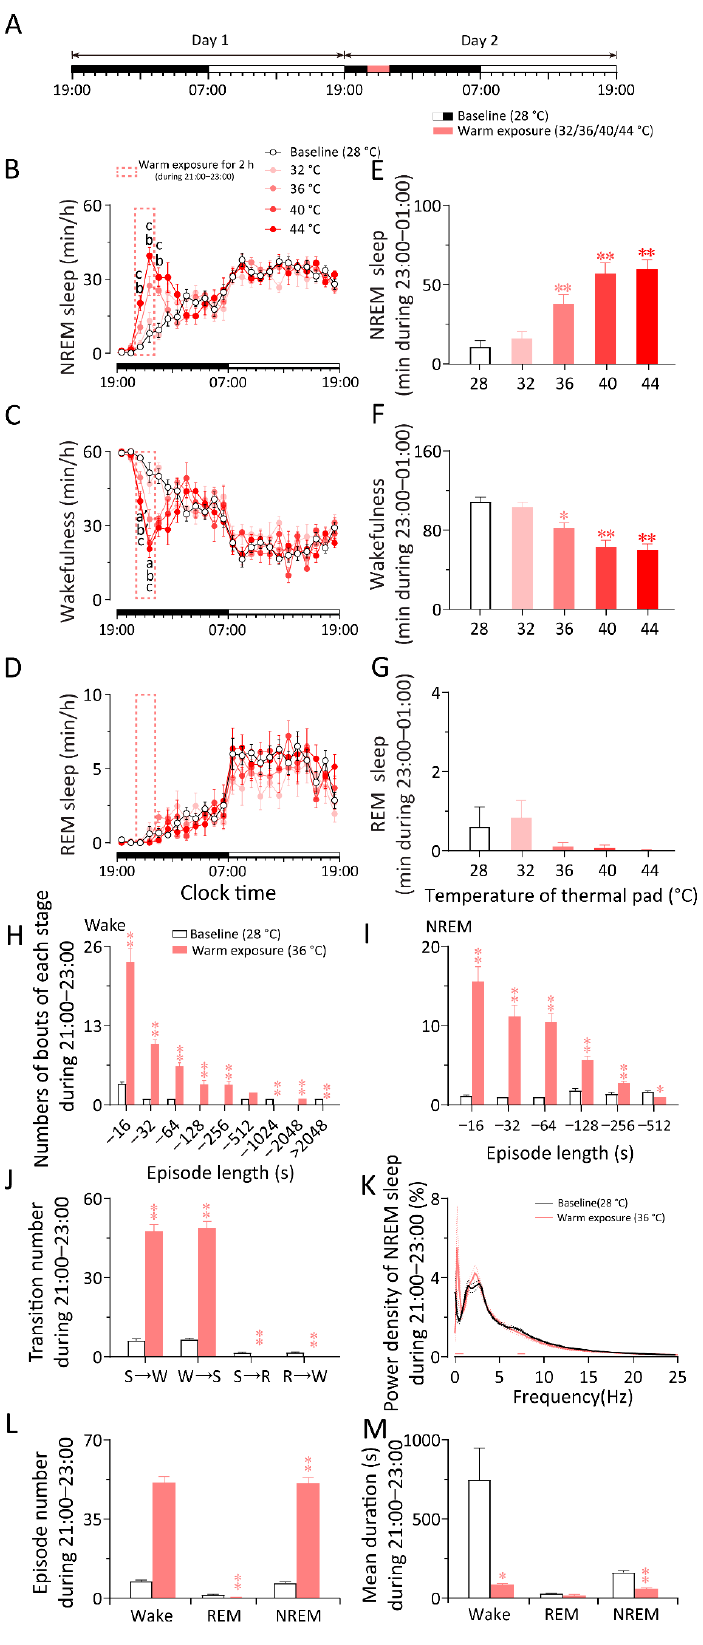
Figure 2. Warm exposure increased NREM sleep and decreased wakefulness in WT mice. ( A ) Schematic diagram of sleep recording and warm exposure. ( B – D ) 24 h time–course changes of NREM sleep ( B